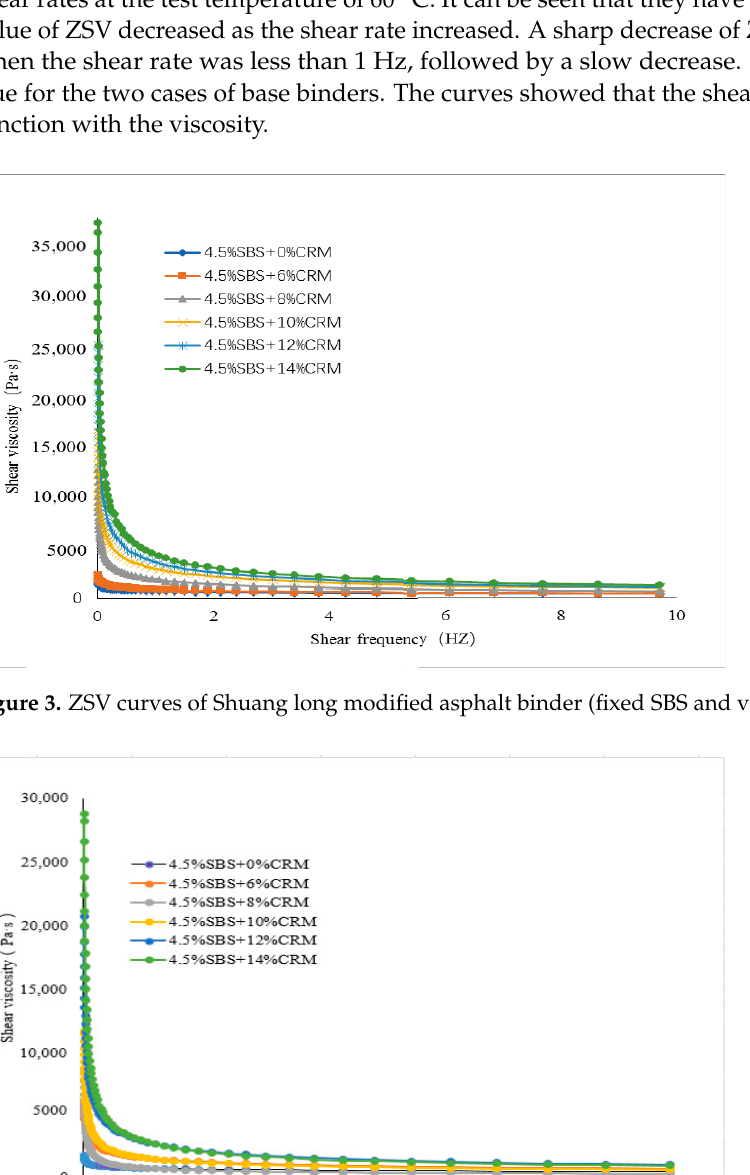
Figure 2. Test route of the properties of Hybrid modified binders.